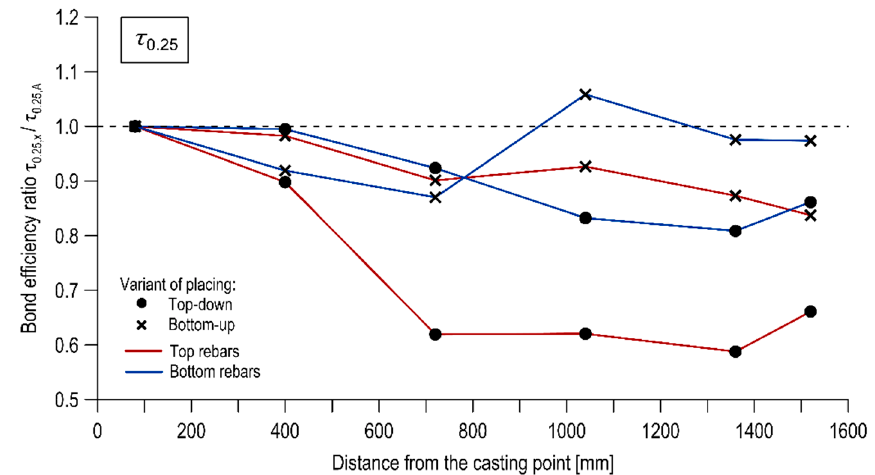
Figure 9. Bond efficiency ratio as a function of rebar position for the critical bond stress.